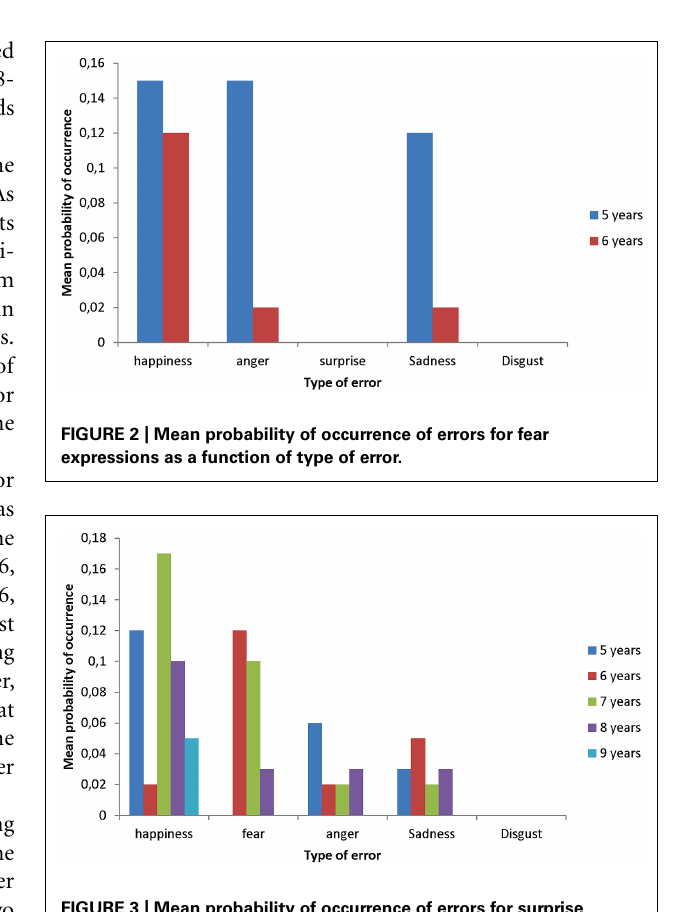
FIGURE 3 | Mean probability of occurrence of errors for surprise expressions as a function of type of